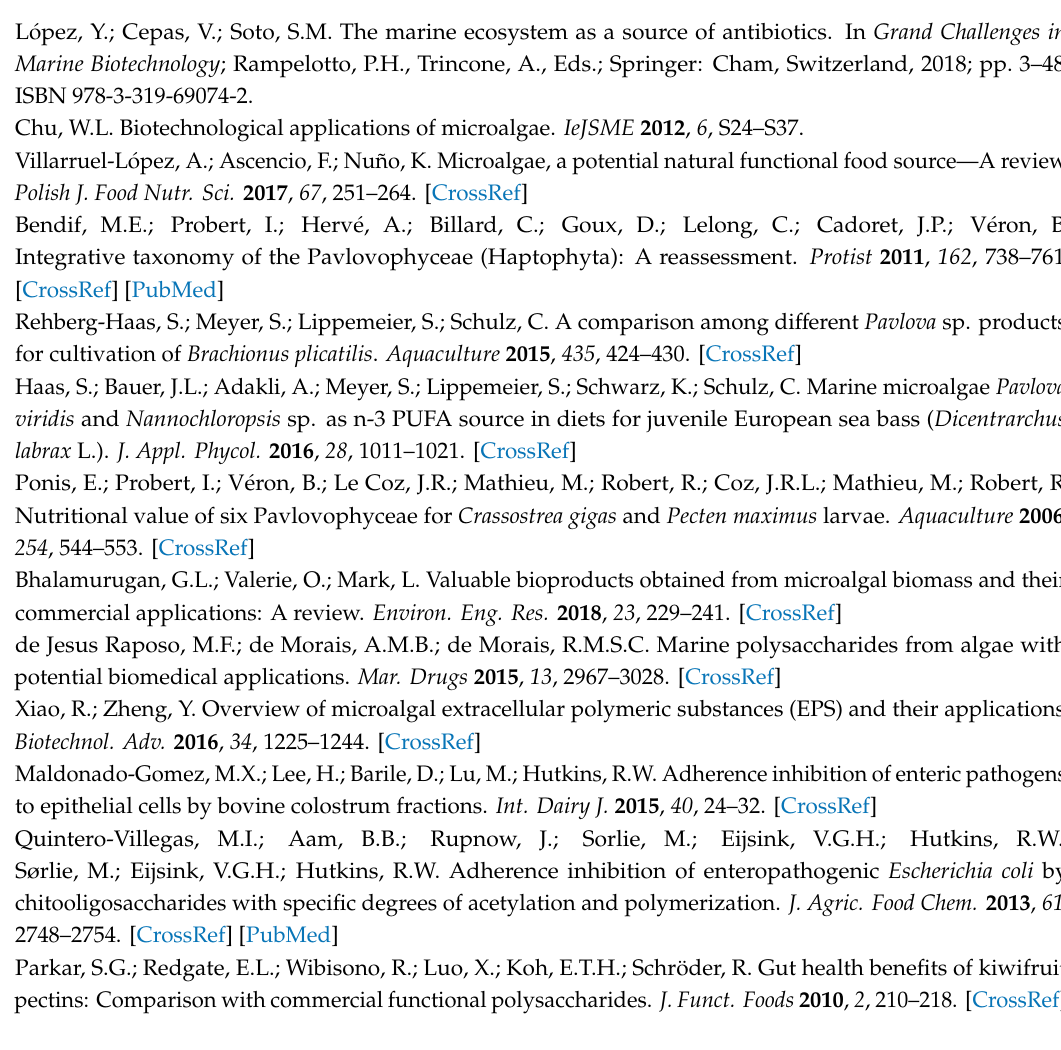
Figure S1: 2D NMR COSY spectrum (400 MHz, Me 2 SO- d 6 , 70 ◦ C) of GW-s, Figure S2: 2D NMR TOCSY spectrum (400 MHz, Me 2 SO- d 6 , 70 ◦ C) of